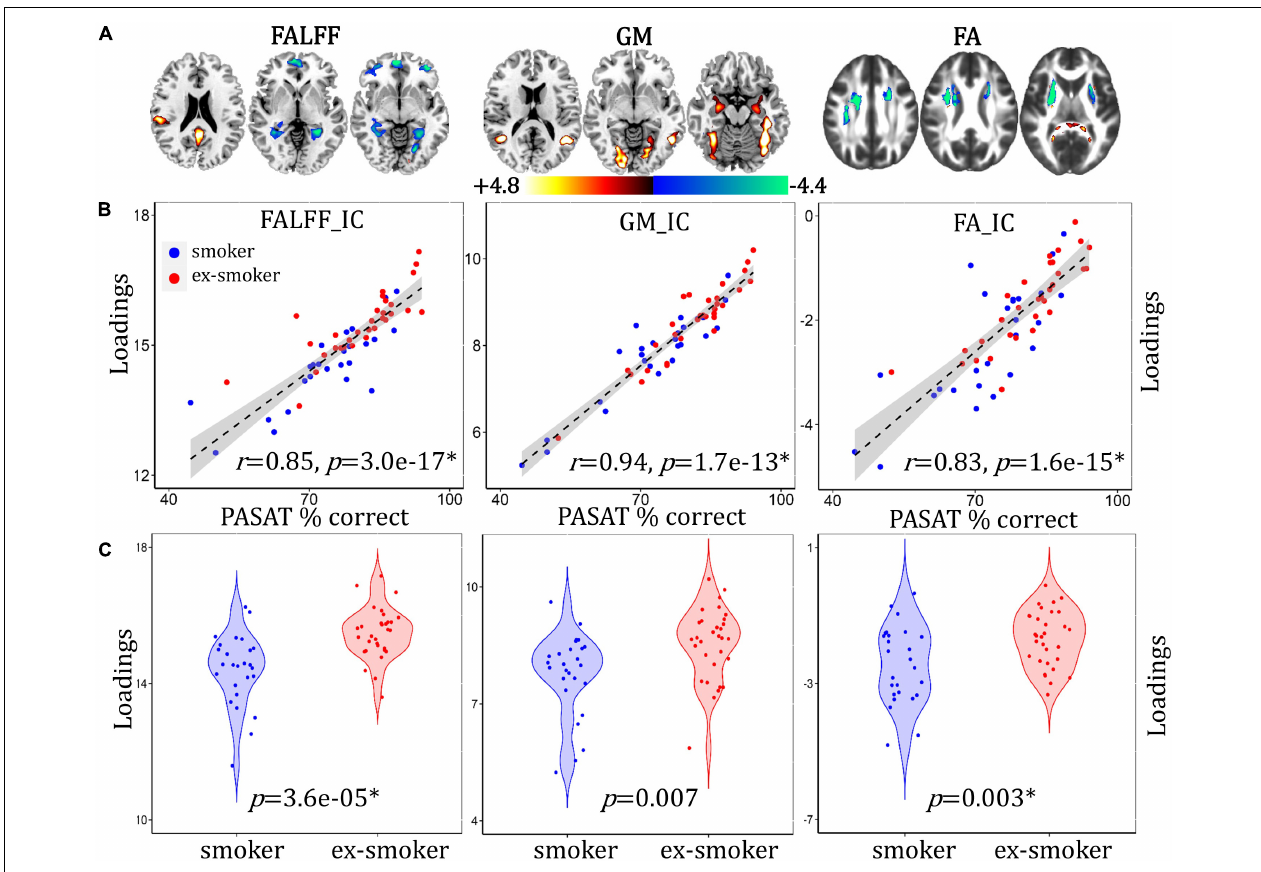
FIGURE 2 | Cognition-associated fALFF + GMV + FA multimodal joint components. (A) The spatial brain independent component (IC) networks visualized at |Z| > 2.5. Regions where smokers > ex-smokers indicated by blue color, regions where ex-smokers > smokers indicated by red color. (B) Correlations between components’ loadings and PASAT% correct. (C) Group difference of the components among smokers and